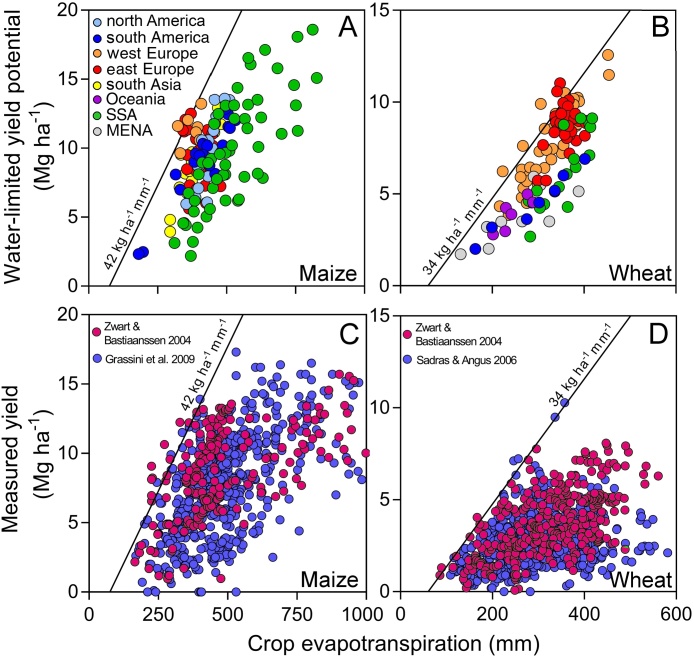
Relationship between simulated water-limited yield potential (Yw) and seasonal water-limited potential crop evapotranspiration (ETw) for (A) maize and (B) wheat across crop producing regions in North and south America, west and east Europe, sub-Saharan Africa (SSA), south Asia, Oceania, and Middle East and North Africa (MENA). Each datapoint corresponds to the 10–20 years average Yw and ETw for a given climate zone. Measured yield versus measured crop evapotranspiration for (C) maize and (D) wheat as reported by Grassini et al. (2009b); Sadras and Angus (2006); Zwart and Bastiaanssen (2004) and references therein. In all panels, solid lines are shown following the French and Schultz (1984) frontier concept, with minimum soil evaporation set at 75 mm for maize (Grassini et al., 2009b) and 60 mm for wheat (Sadras and Angus, 2006), and WPw set at 42 and 34 kg ha−1 mm−1 for maize and wheat, respectively (Connor et al., 2011). The boundary functions and data from the literature were expressed at 15.5% (maize) and 13.5% (wheat) grain moisture content.